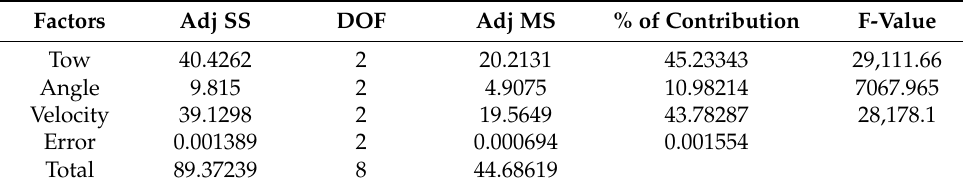
Table 6. ANOVA results for erosion rate.